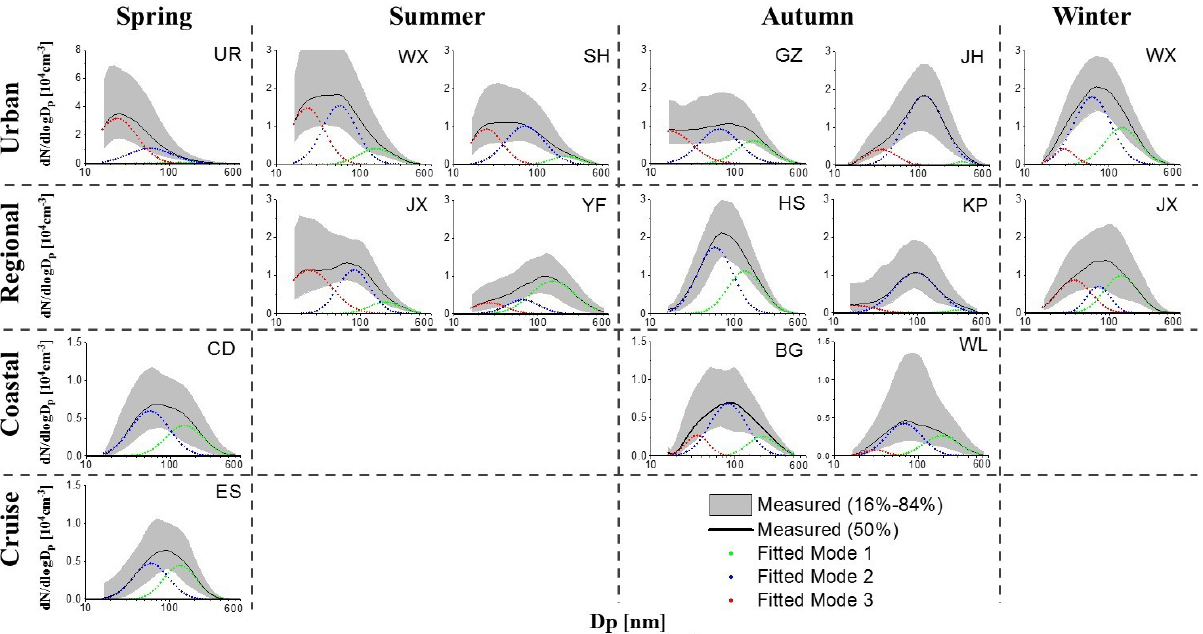
Figure 2. Median distribution (solid black line), 16th and 84th percentile distribution (shaded areas) and fitted modes (green, blue and red scatter dots) at all the measurement